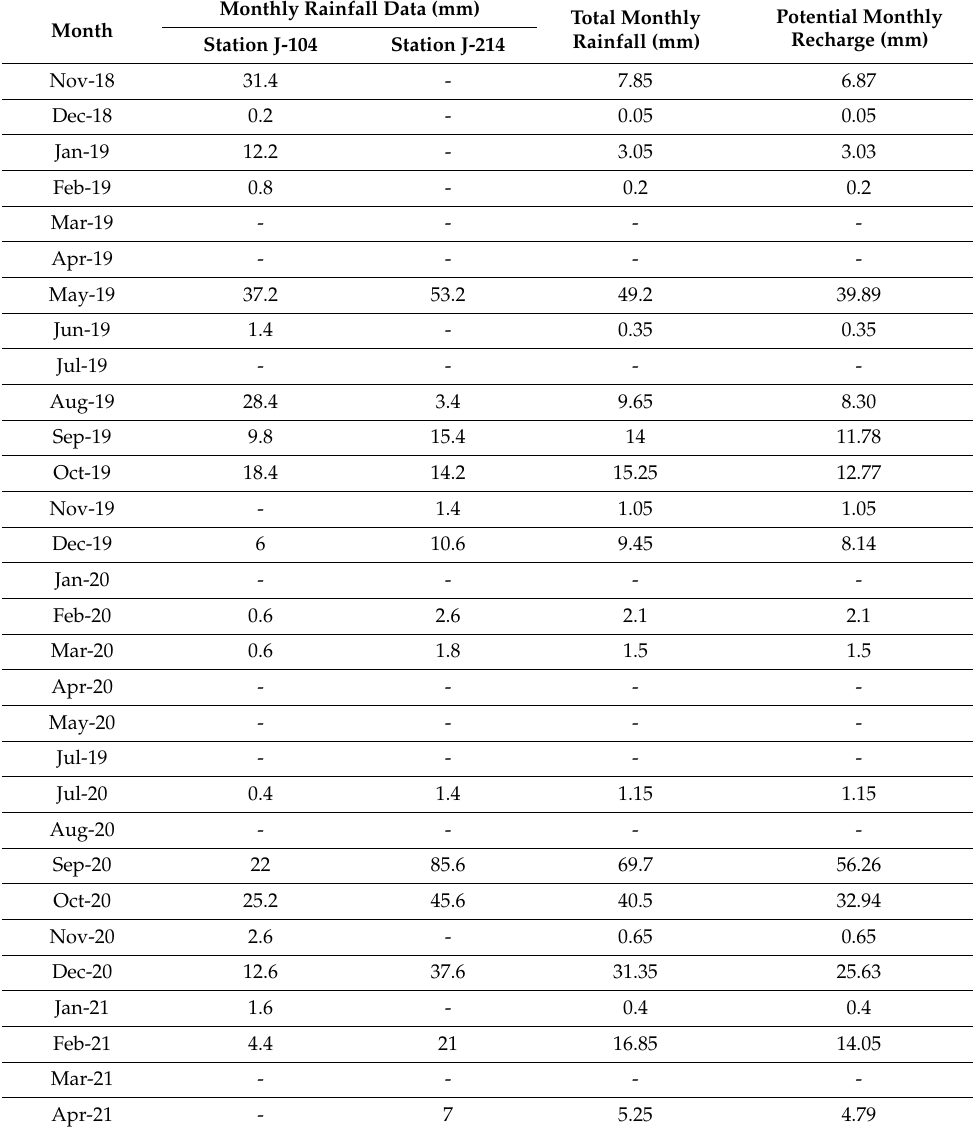
Table 7. Potential recharge based on monthly rainfall